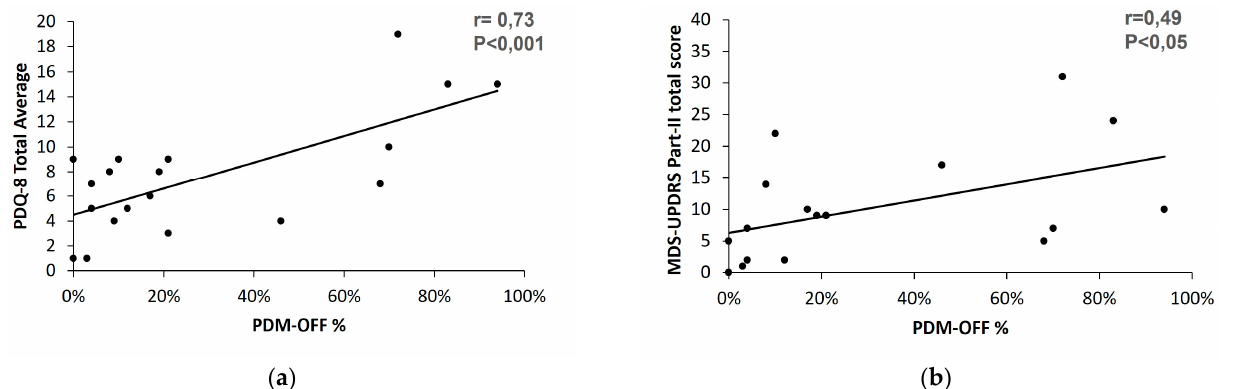
Figure 11. Correlation plots of the PDMonitor ® percent time OFF with the ( a ) total average score of the PDQ-8 questionnaire and ( b ) part II total score.